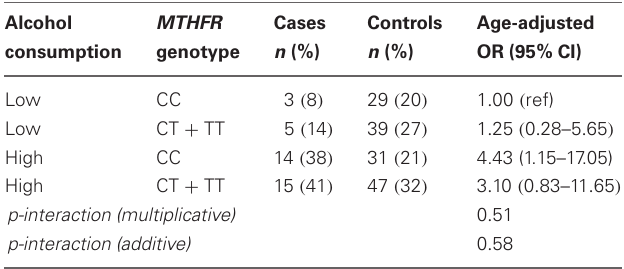
Table 5 | Alcohol consumption, MTHFR C677T genotype, and prostate cancer risk (37 cases; 146